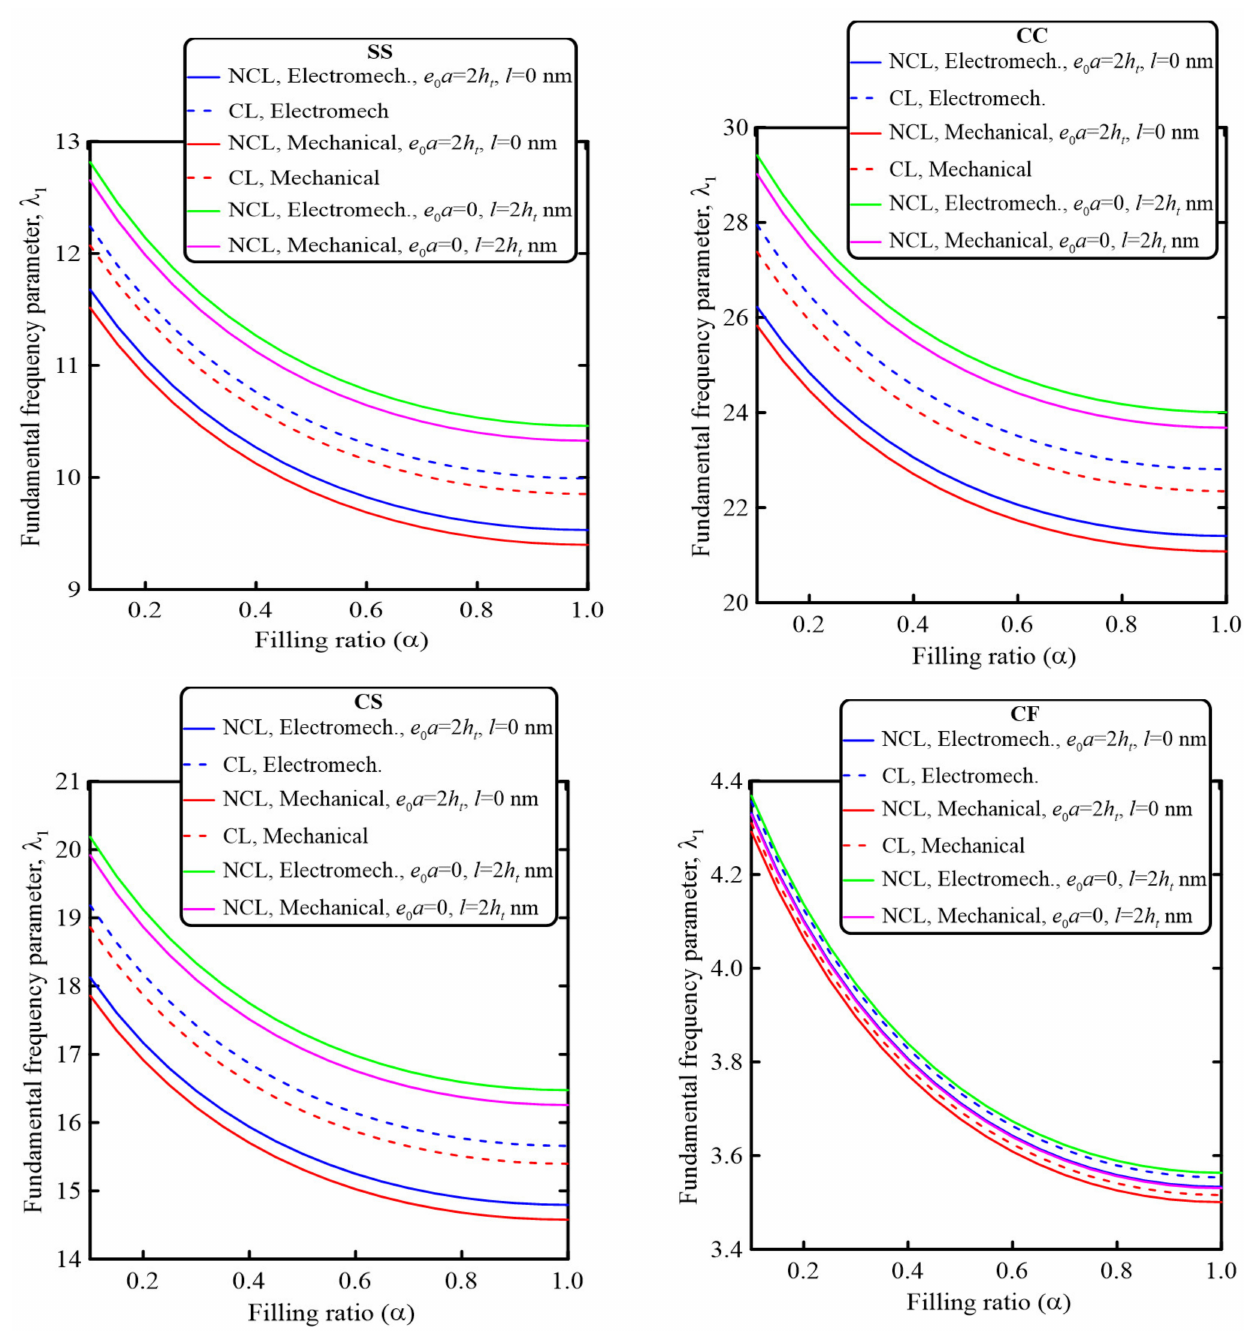
Figure 2. Variation of the fundamental frequency parameter λ 1 with the perforation filling ratio for nonclassical and classical electromechanical and mechanical analyses of piezoelectric sandwich nanobeams for different beam boundary conditions at N = 4 and beam aspect ratio L / h t = 20 (N =